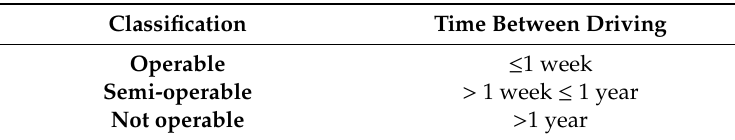
Table 2. Classification of passive methods by time between